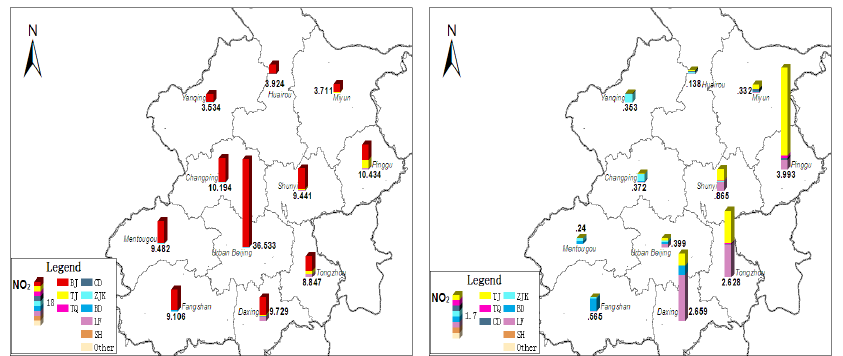
Fig. 12. Same as Fig. 7 but for NO 2 , concentration unit: ppbv. Table 7. Percentage of Beijing local production and surrounding areas contribution to daily ozone concentration in urban Beijing at the surface